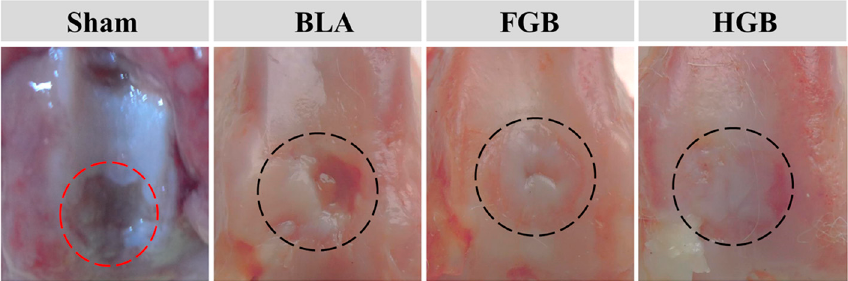
Figure 6. Macroscopic appearances of joint cartilage in experimental groups at 12 weeks after transplantation. The red cycle indicates the antigen-induced arthritis damage in Sham group, and the black cycles indicate the areas of cartilage repair in BLA, FGB, and HGB groups.